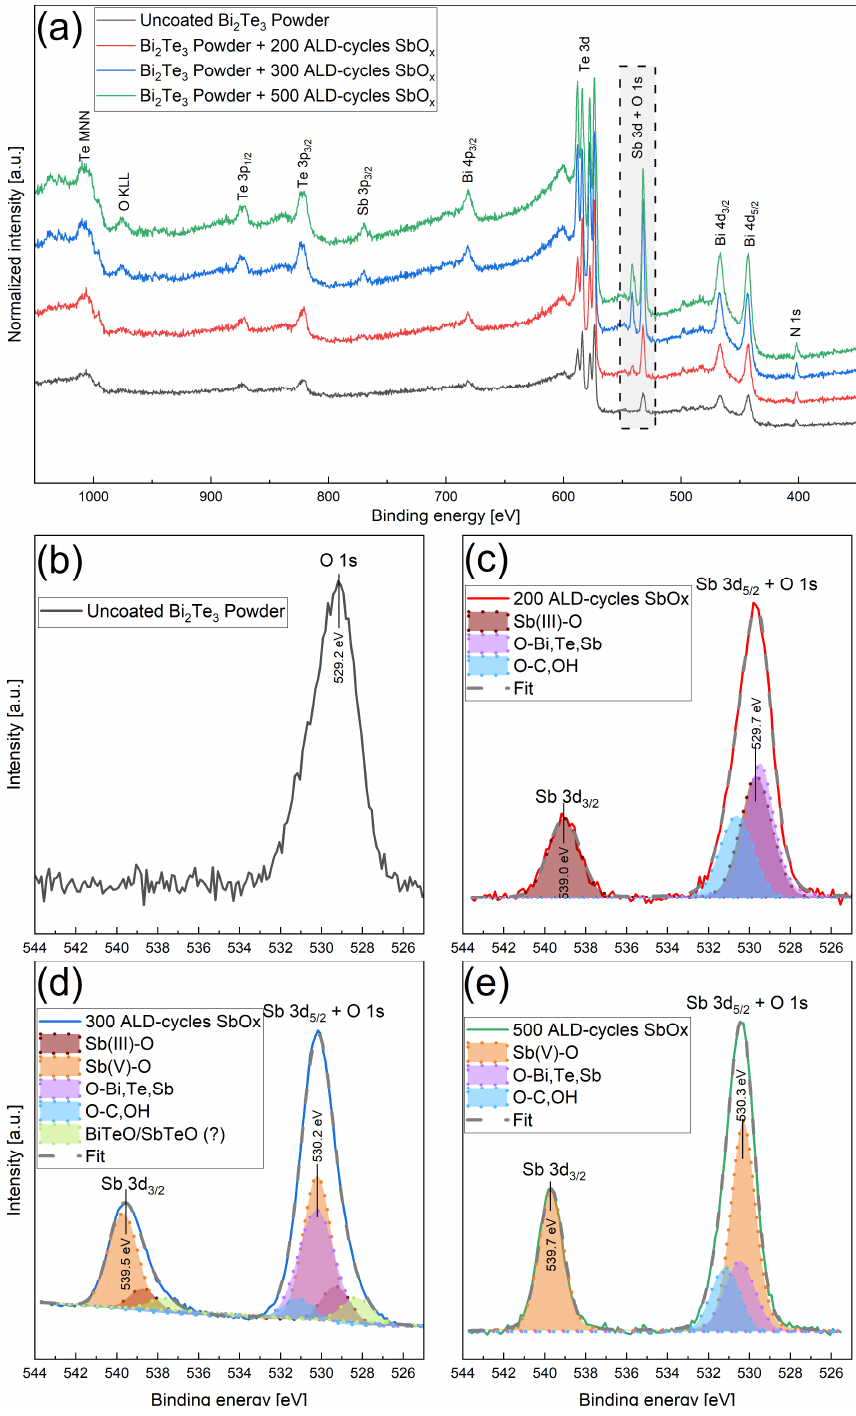
Figure 5. ( a ) XPS survey spectrum of Bi 2 Te 3 particles uncoated and SbO x -coated for 200, 300, and 500 ALD cycles. ( b – e ) Sb 3d + O 1s regions of Bi 2 Te 3 particles uncoated and SbO x -coated for 200, 300, and 500 ALD cycles.